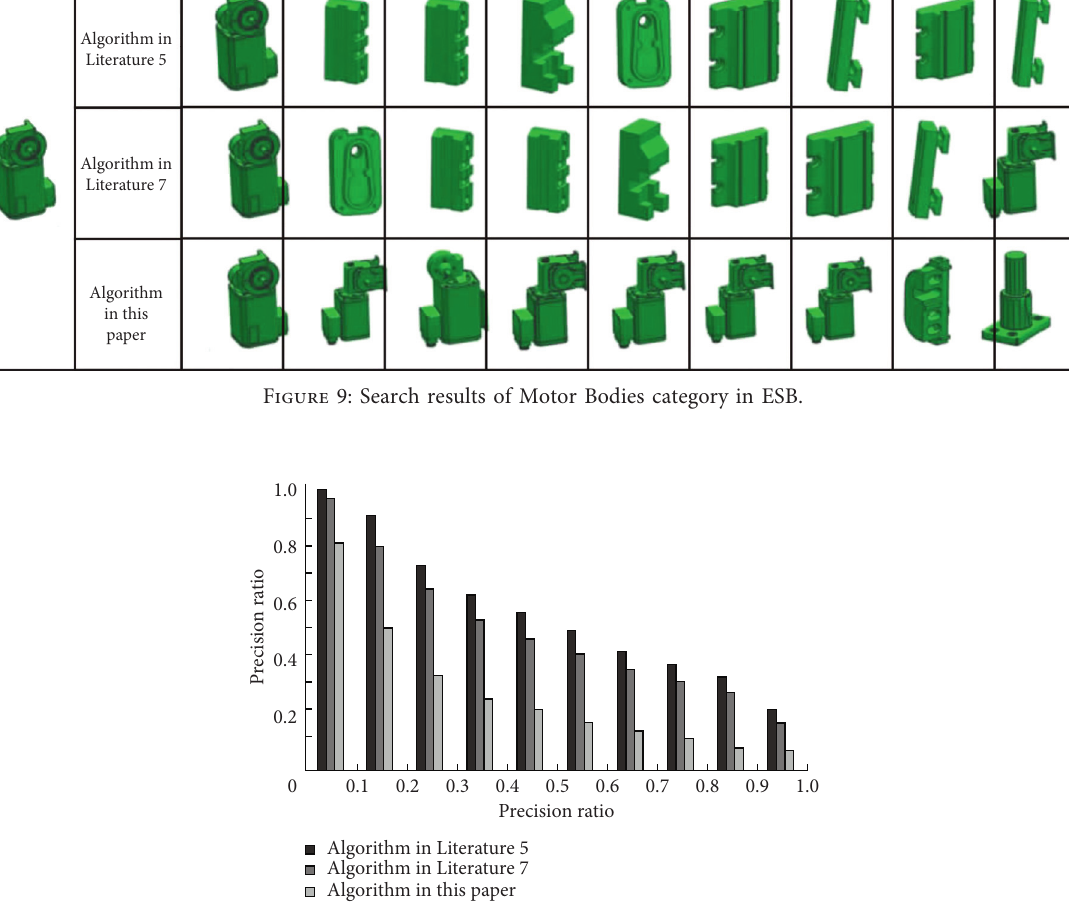
Figure 10: Comparison of the retrieval efficiency of the three algorithms on the model retrieval in the ESB model library.